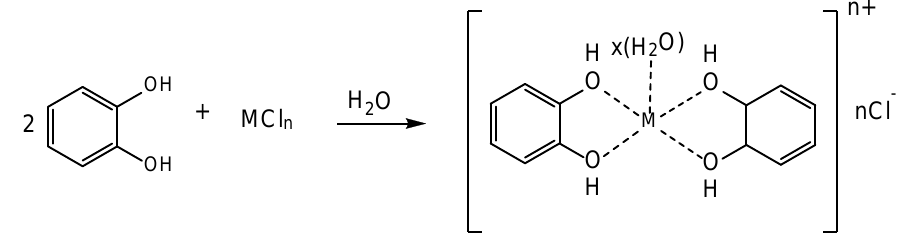
Figure 1. The preparation process of the catechol metal complex (M = Cr, Mn, Fe, Co, Ni, Cu, Zn).